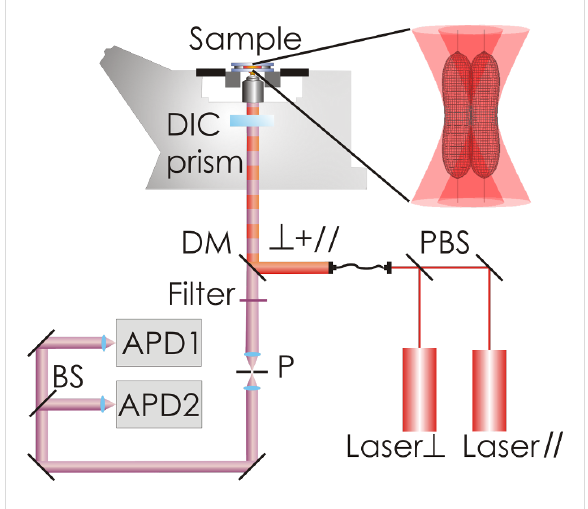
Figure 4: Schematic of the 2fFCS system. DM: dichroic mirror; BS: beam splitter; PBS: polarizing beam splitter; APD: avalanche photo diode; P: